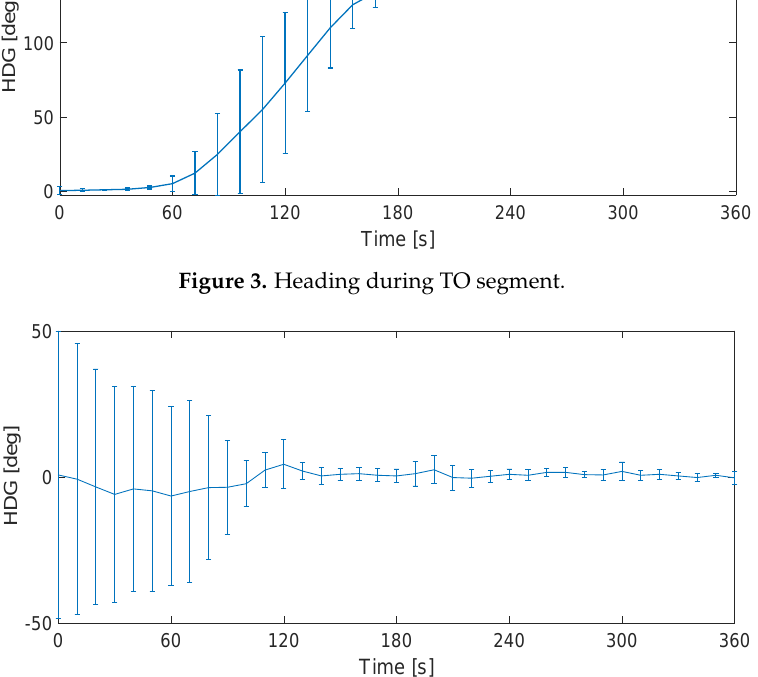
Figure 4. Heading during LA